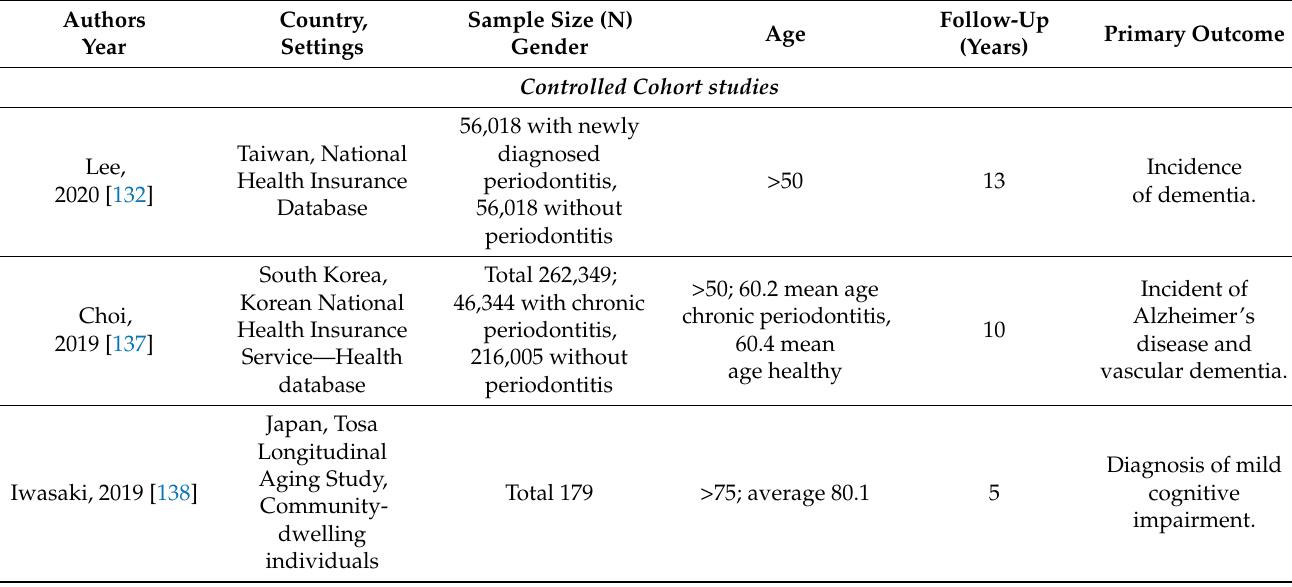
Figure 4. PRISMA flow diagram for systematic review summarizing the results of searches of electronic databases [122,123]. Identification of studies via databases using keywords and MESH terms. Total number across all databases, records included as per eligibility criteria, records excluded, articles included in meta-analysis (data synthesis). Table 1. Primary characteristics of 17 included